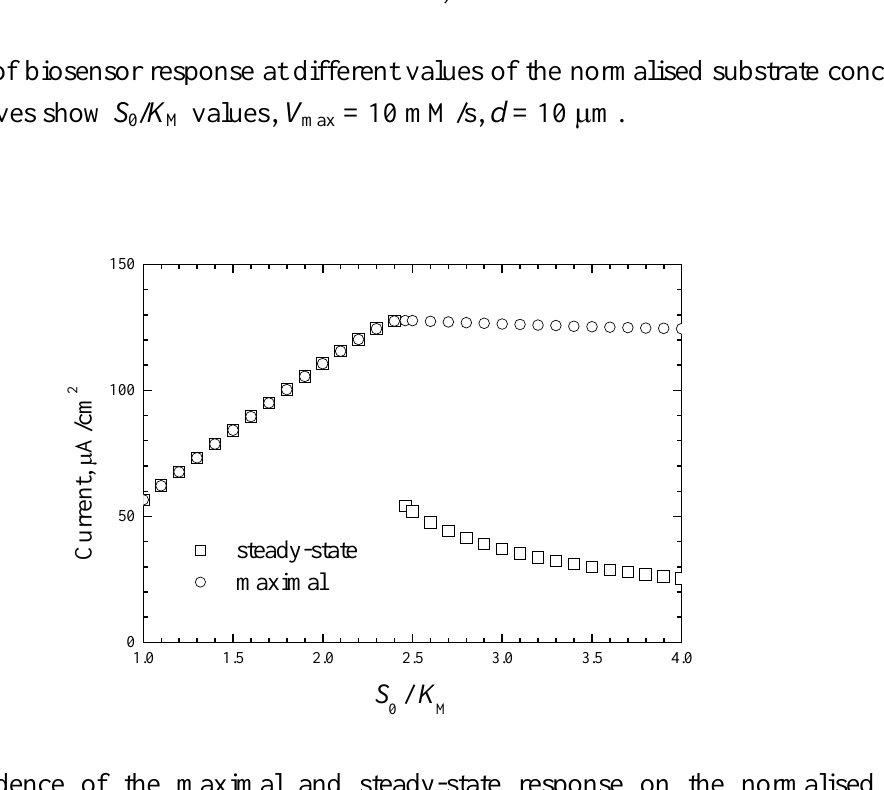
Figure 6 . Dependence of the maximal and steady-state response on the normalised substrate concentration. Calculation parameters as in Fig.